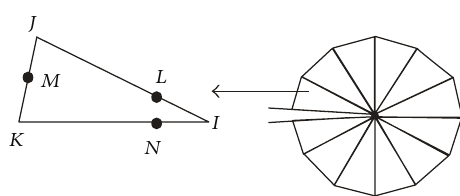
Figure 7: Six node triangular elements around a crack tip.